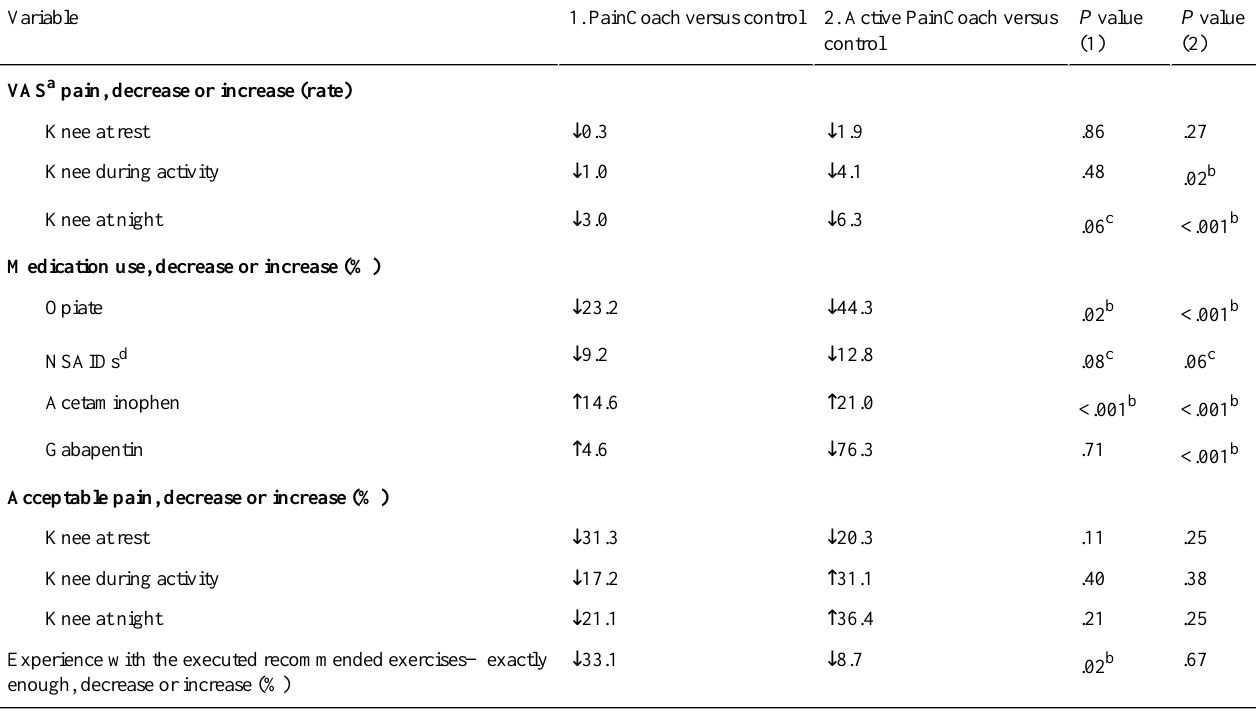
Table 3. Findings in the PainCoach group, active PainCoach subgroup, and control group during the first 2 weeks at